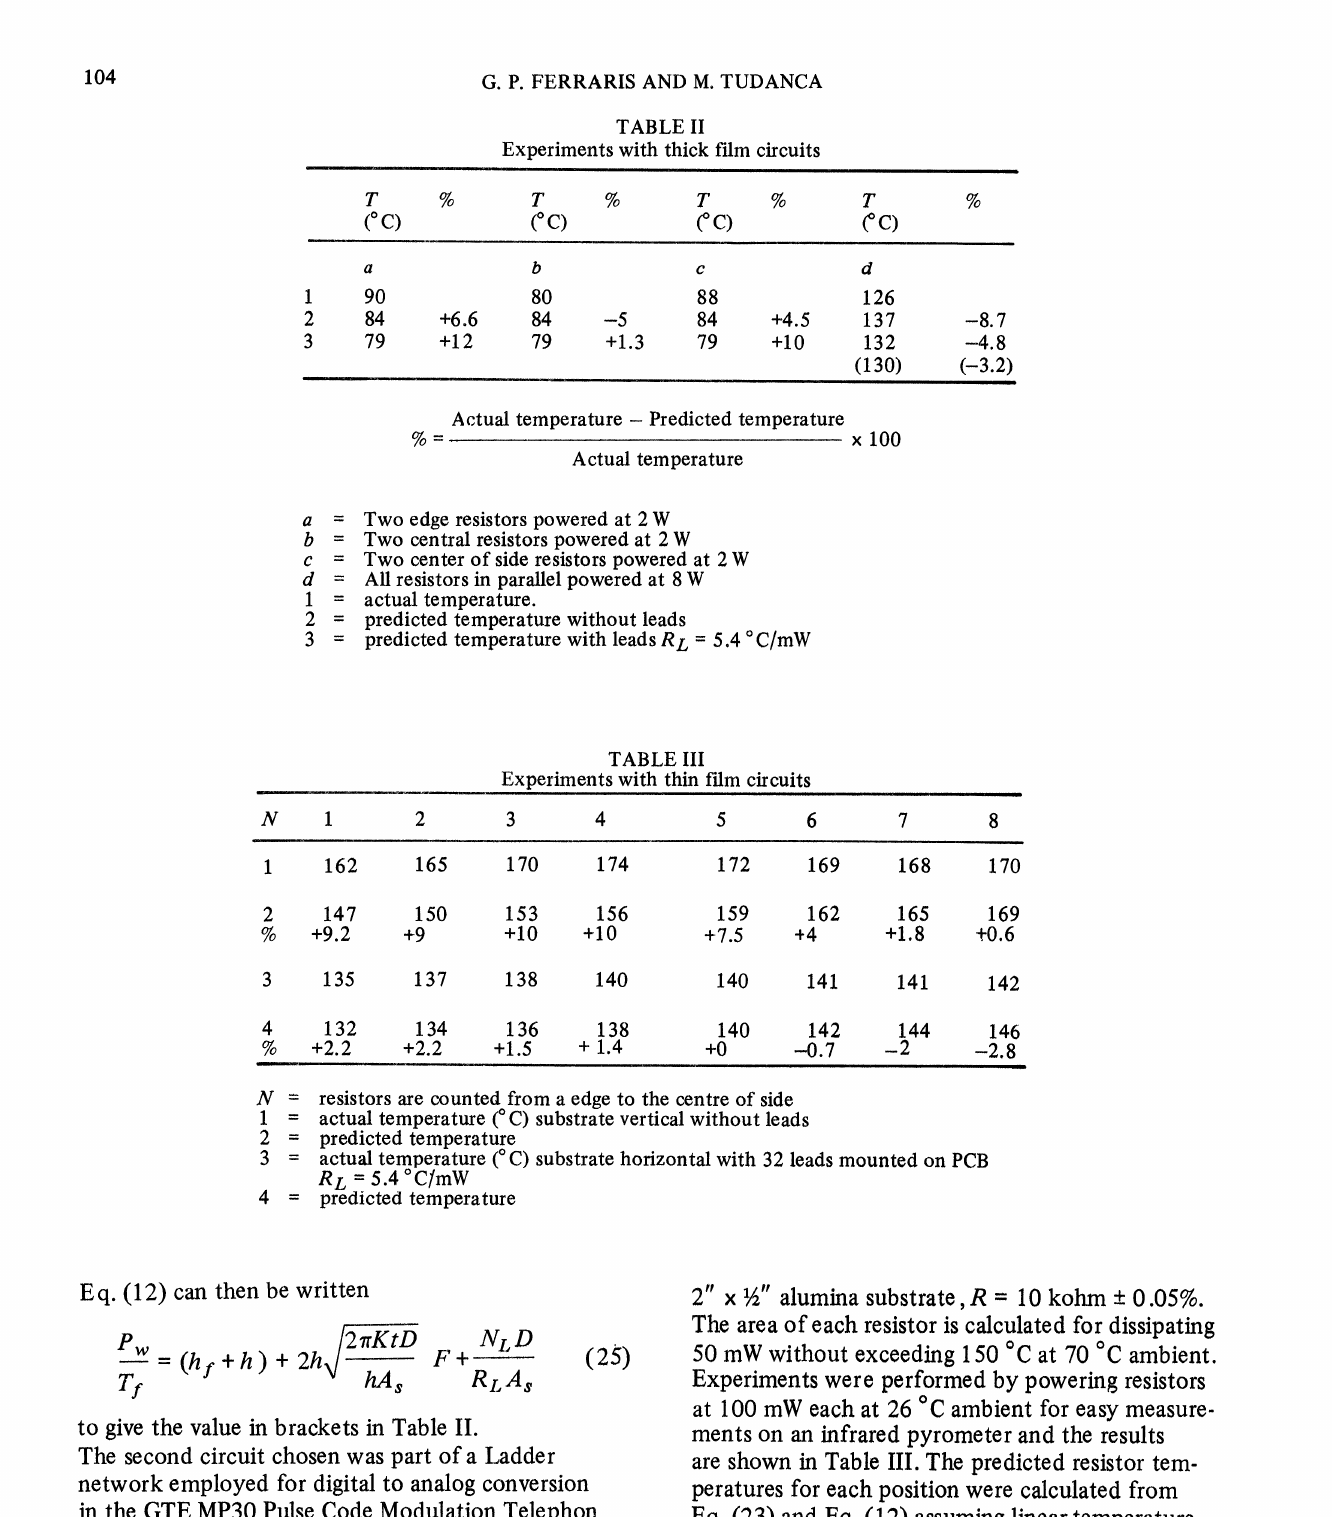
TABLE II Experiments with thick film circuits